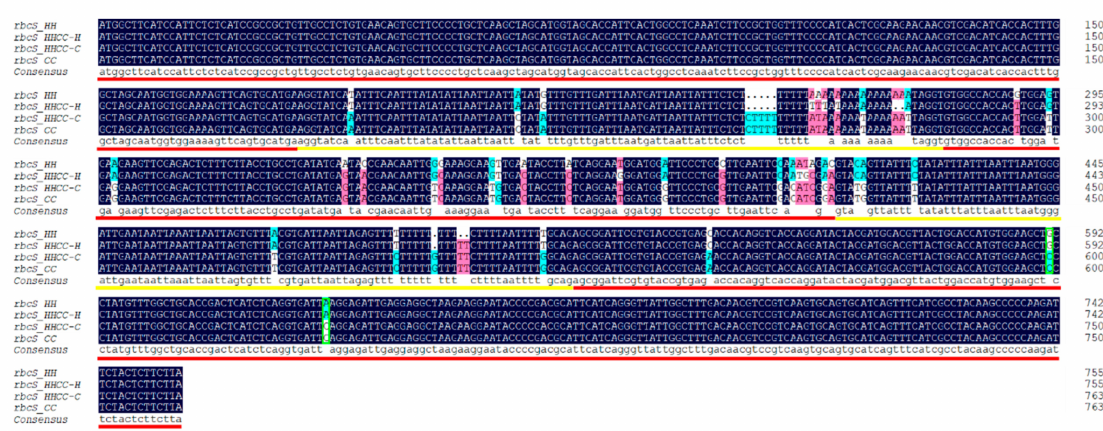
Figure 2. Sequence alignment of allopolyploid C. × hytivus (HHCC) RuBisCO coding gene rbcS with those from the progenitor diploid (HH and CC) rbcS genes. The red and yellow lines represent the three exons and two introns, respectively. Homoeo-SNPs (homoeo-single nucleotide polymorphisms) at positions 599 (where HH orthologs had a G, but CC orthologs had a C) and 636 (where a HH orthologs had an A, but CC orthologs had a C) are annotated in green